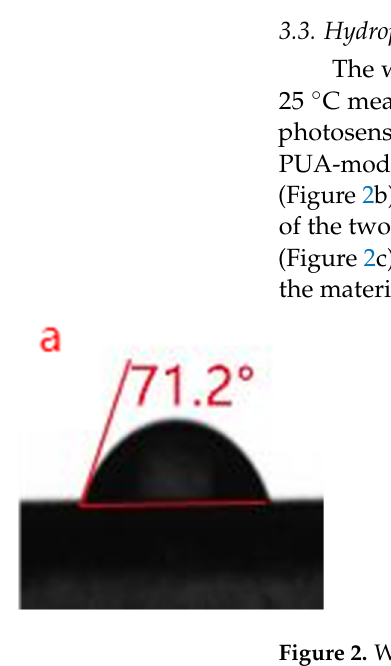
Figure 1. FTIR spectra of free − radical/cationic hybrid (UVR), polyurethane acrylates (PUA, 20%)